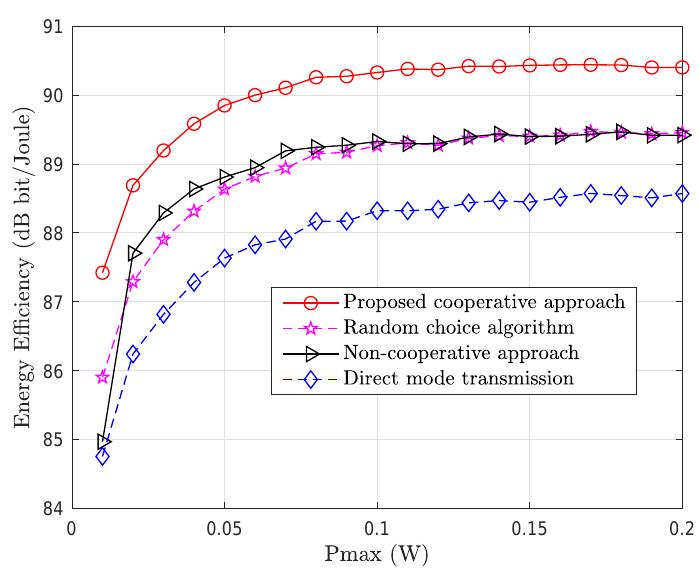
Figure 4. Energy efficiency varying the maximum transmit power. Three different algorithms are compared. M and K in this case change randomly from 1 to 10.